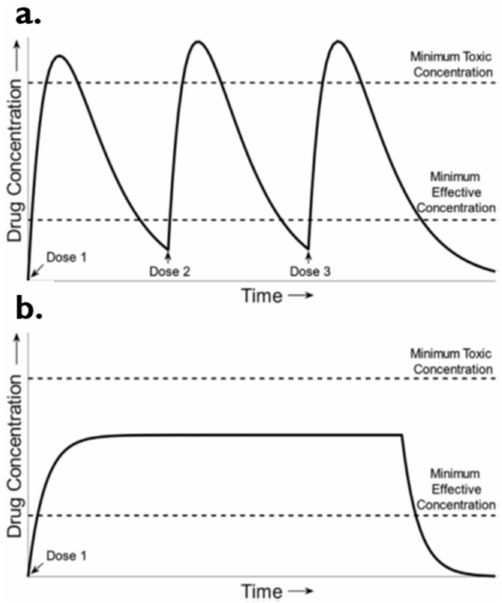
Figure 20. A typical bolus of ( a ) Conventional DDS; ( b ) Controlled